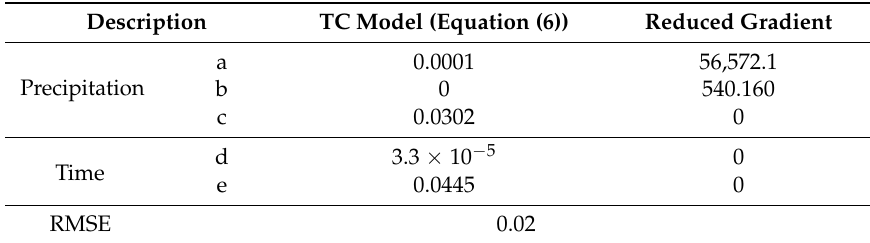
Figure 5. Mean coherence values of all buildings calculated from the sequential SAR coherence (black circles) and the modeled mean coherence (orange circles). The gray band delimits the standard deviation bounds on the coherence. Table 1. Summary of the TC model.